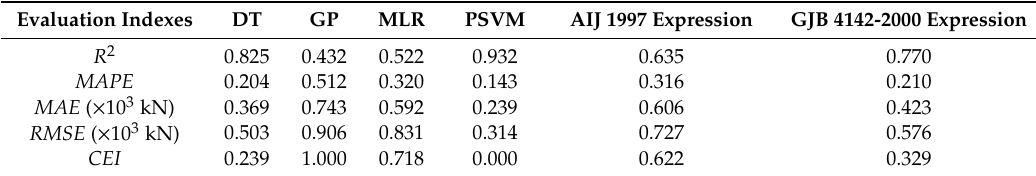
Table 2. Prediction performance evaluation of DT, GP, MLR, PSVM, AIJ 1997, and GJB 4142-2000 expressions in the training set.